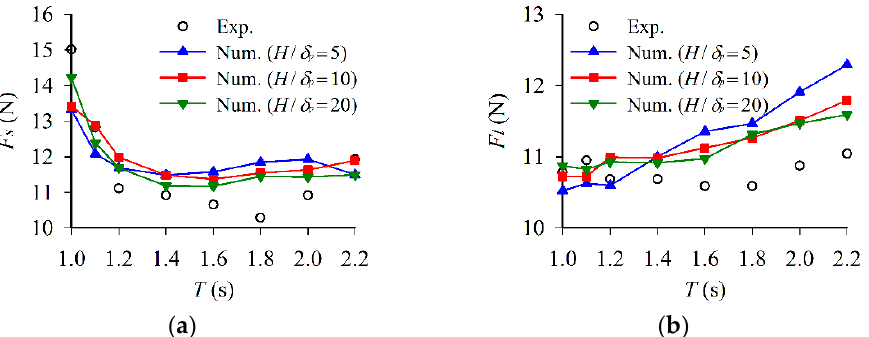
Figure 7. Comparison of the experimental and numerical mooring force of the cuboid floating pontoon: ( a ) Seaward side F s ; ( b ) Leeward side F l .